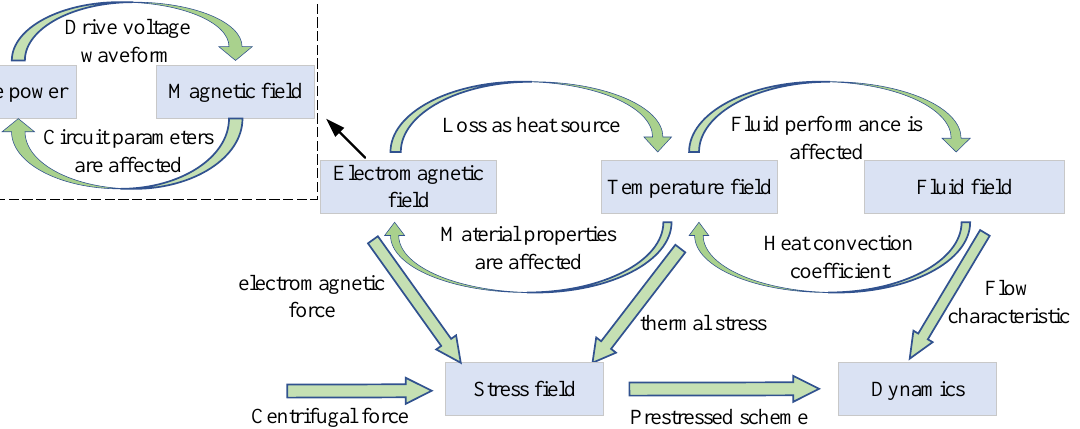
Figure 24. Mutual coupling relationship between multiple physical